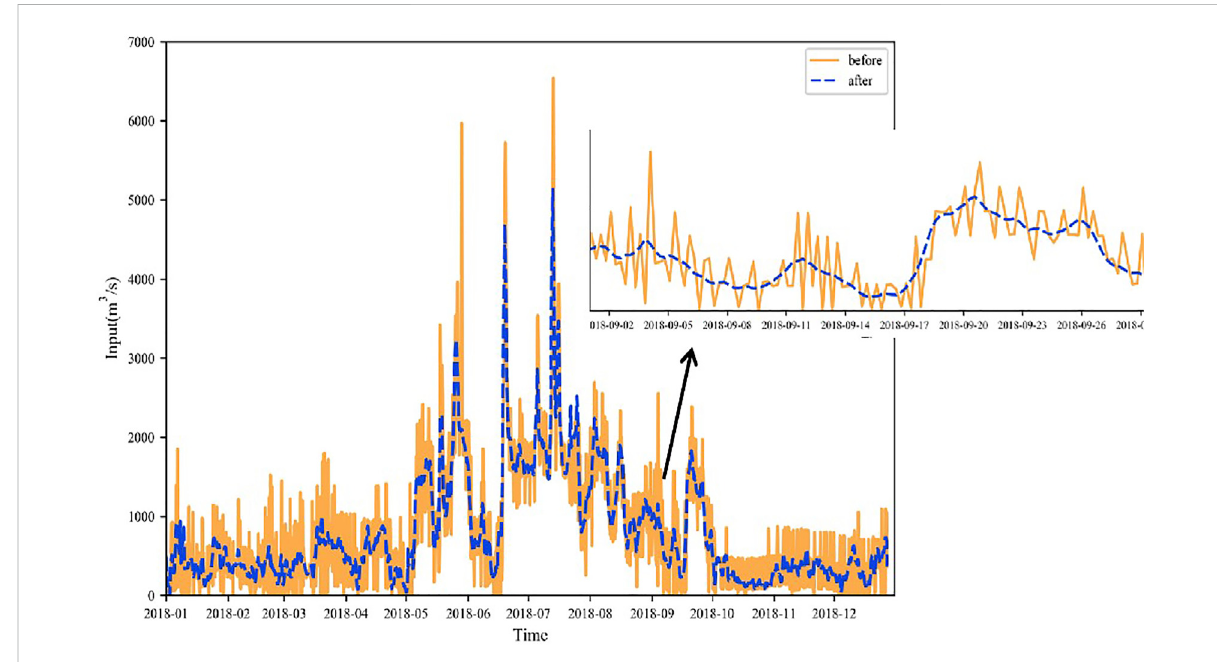
FIGURE 5 The comparison of data of Danjiangkou Reservoir in 2018 before and after